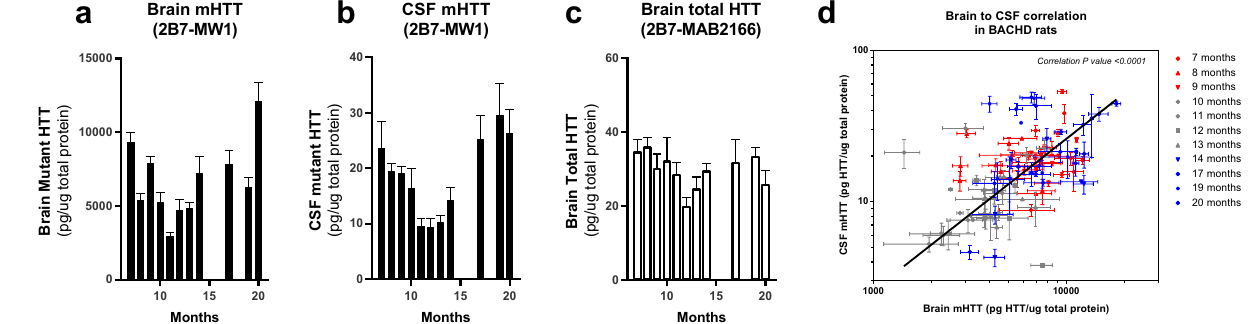
Figure 8. CSF and brain HTT and mHTT levels in a BACHD life-span study. ( a ) Brain mHTT levels as measured by the 2B7-MW1 SMC assay in a cohort of c. 10 BACHD rats for time point. ( b ) CSF mHTT levels as measured by the 2B7-MW1 SMC assay in a cohort of c. 10 BACHD rats for time point. ( c ) Brain levels of total HTT as measured by the 2B7-MAB2166 SMC assay in a cohort of c. 10 rats for time point. ( d ) Correlation (non-parametric Spearman correlation, two-tailed p value, confidence interval = 95%, p < 0.0001, r 2 = 0.52) of mHTT levels between brain (x-axis) and CSF (y-axis) at multiple time points (symbol shapes) and age periods (colours) as measured by the 2B7-MW1 SMC assay. Every experimental point is reported as average and standard deviation of a technical triplicate. All numeric values are available in the supplementary material S-10.